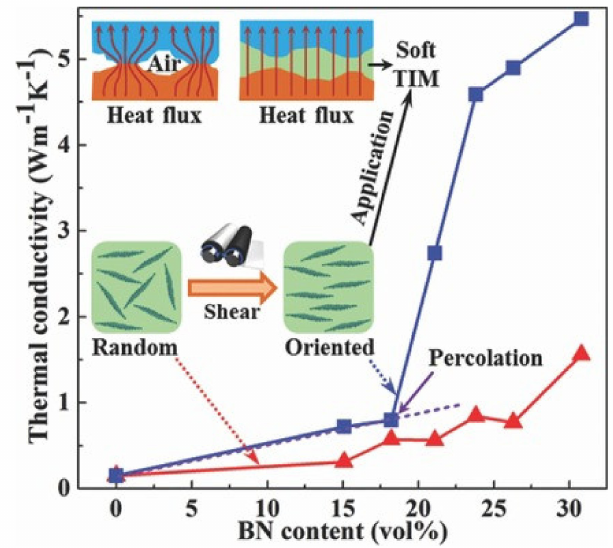
Figure 13. Thermal conductivity of BNNSs/SiR and BNNSs/NR nanocomposites as a function of filler loading [171]. Copyright© 2021 WILEY-VCH Verlag GmbH & Co. KGaA, Weinheim. All rights